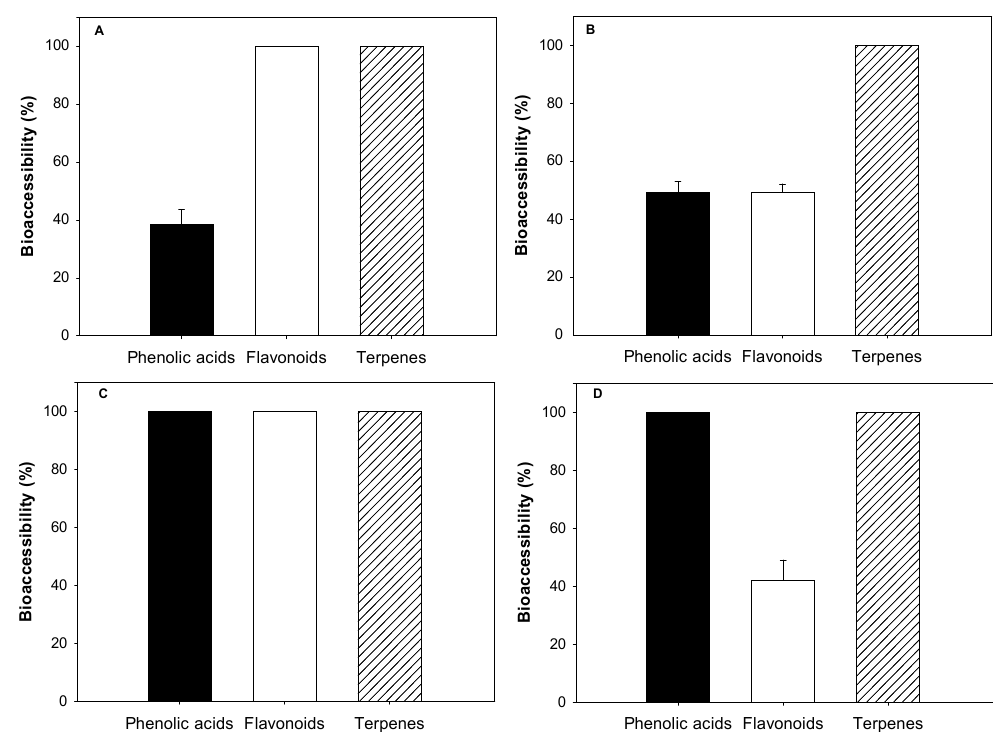
Figure 5. Bioaccessibility of phenolic acids, flavonoids and terpenes of avocado peel ( A , B ) and seed ( C , D ) extracts of oil-in-water (O/W) dispersions ( A , C ) and emulsions stabilized with LMP ( B , D ).